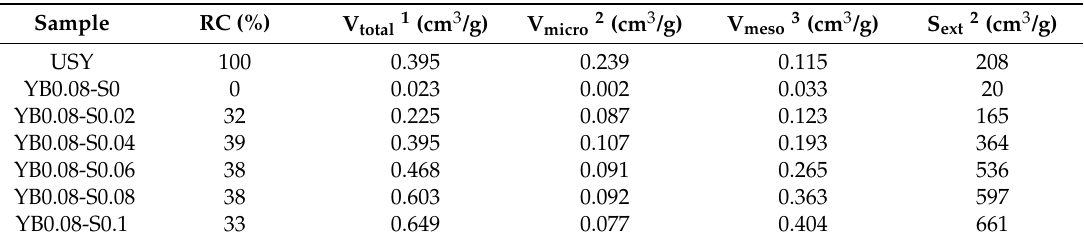
Table 2. Relative crystallinity (RC) and textural properties of the modified zeolites, according to the amount of surfactant used during the modification.